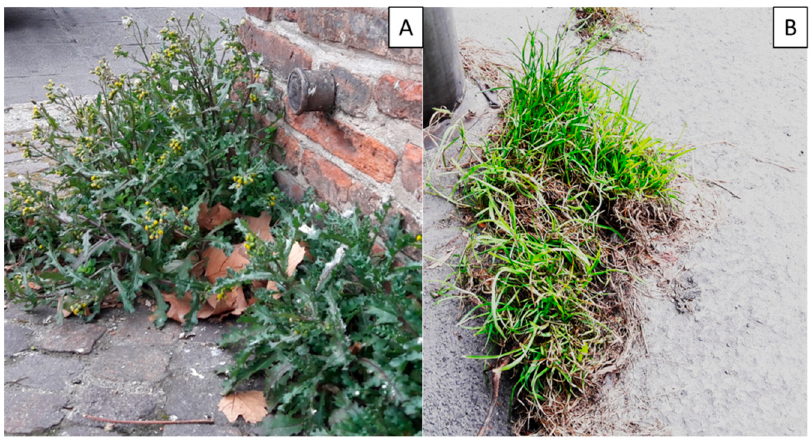
Figure 5. ( A ) Senecio vulgaris growing at a busy street crossing in Bologna. ( B ) Poa annua growing on the sidewalk in Milan.